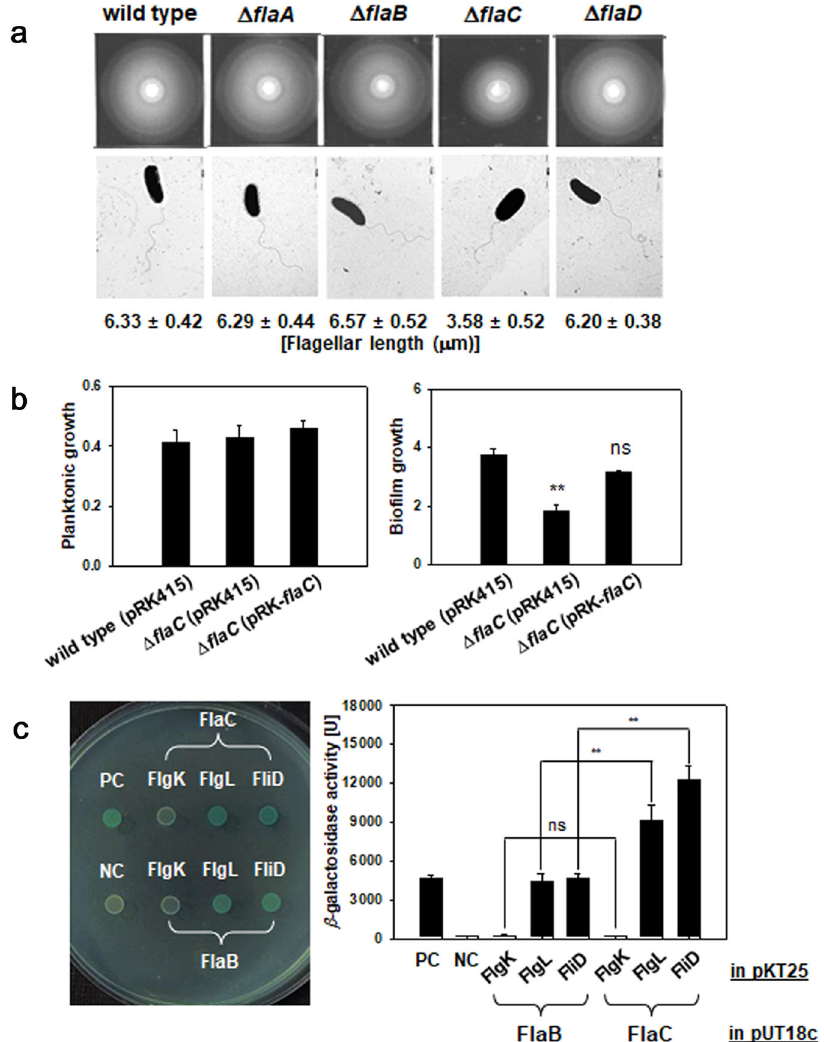
Fig. 8 Roles of FlaC in fl agellation and fl agellum-mediated behaviors. a Swimming motility and fl agellar lengths. Five microliters of the freshly grown cultures (at an OD of 1.0) of V. vulni fi cus strains of wild type, Δ fl aA , Δ fl aB , Δ fl aC , and Δ fl aD were spot-inoculated on a soft-agar plate made of LBS containing 0.3% agar and incubated at 30 °C for 6 h (upper images). Individual cells of V. vulni fi cus strains were observed under TEM to examine their polar fl agella (lower images with the fl agellar lengths [in μ m] estimated from at least 20 cells of each strain), as described in “ Methods ” . b Bio fi lm formation by Δ fl aC . Standard bio fi lm assay using borosilicate tubes was performed with the wild type carrying pRK415, Δ fl aC carrying pRK415, and Δ fl aC carrying pRK415- fl aC . At 48 h post-inoculation, the planktonic cell density was measured by spectrophotometry at 595 nm (OD 595 ), and bio fi lm growth was estimated by staining with crystal violet and subsequent spectrophotometry at 550 nm (OD 550 ). c Interaction of FlaC with other components of a fi lament. To examine whether FlaC differentially interacts with the hook- associated proteins (FlgK and FlgL) and/or capping protein (FliD) constituting a polar fl agellum 66,67 , a bacterial two-hybrid system expressing β -galactosidase was utilized. E. coli BTH101 cells containing pUT18c- fl aC /pKT25- fl gK , pUT18c- fl aC /pKT25- fl gL , or pUT18c- fl aC /pKT25- fl iD , were spotted on an LBS agar plate supplemented with 40 μ g/ml X-gal ( a left image). The β -galactosidase activities were quanti fi ed using ONPG and presented as Miller units. For comparison, pUT18c carrying the fl aB gene instead of fl aC was also used for combination with pKT25 carrying fl gK , fl gL , or fl iD . The positive (PC) and negative controls (NC) were E. coli BTH101 containing pUT18c- zip /pKT25- zip and pUT18c/pKT25, respectively. The P- values for comparison between FlaC and FlaB were indicated (Student ’ s t -test; ** P < 0.005, ns, not signi fi cant). The error bars on the bar charts represent standard sensing the speci fi c signals or parameters representing the stages of bio fi lm formation. The induced expression of degP , under the determined. Some signals have been shown to play roles in conditions of extracytoplasmic stresses, has been shown to be controlled at the level of its transcription via RpoE, whose activities were modulated by actions of some heat-shock proteases 39 – 41 . In addition to RpoE, it is also regulated by a two-component regulatory system, CpxRA 42 . Although the genes of degQ and degS are mapped in an operon-like arrangement, each gene appears to be transcribed independently and their expressions are not heat- inducible in E. coli 41 . Signal(s) turning on or off the degQ gene in